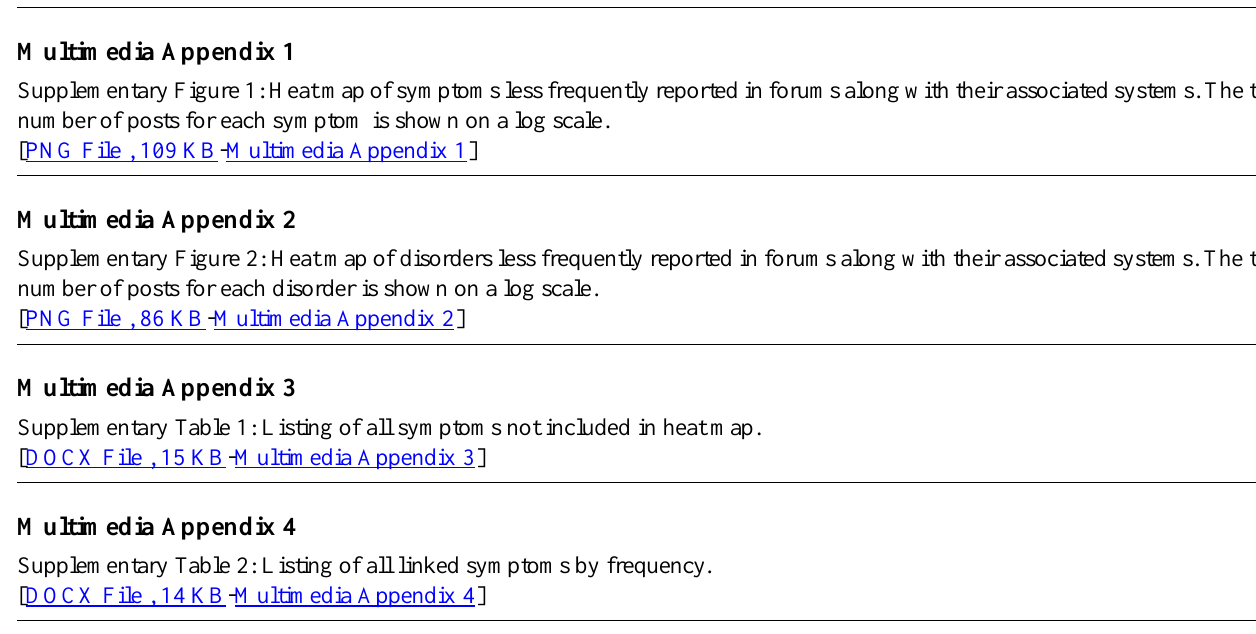
Supplementary Figure 1: Heat map of symptoms less frequently reported in forums along with their associated systems. The total number of posts for each symptom is shown on a log scale.